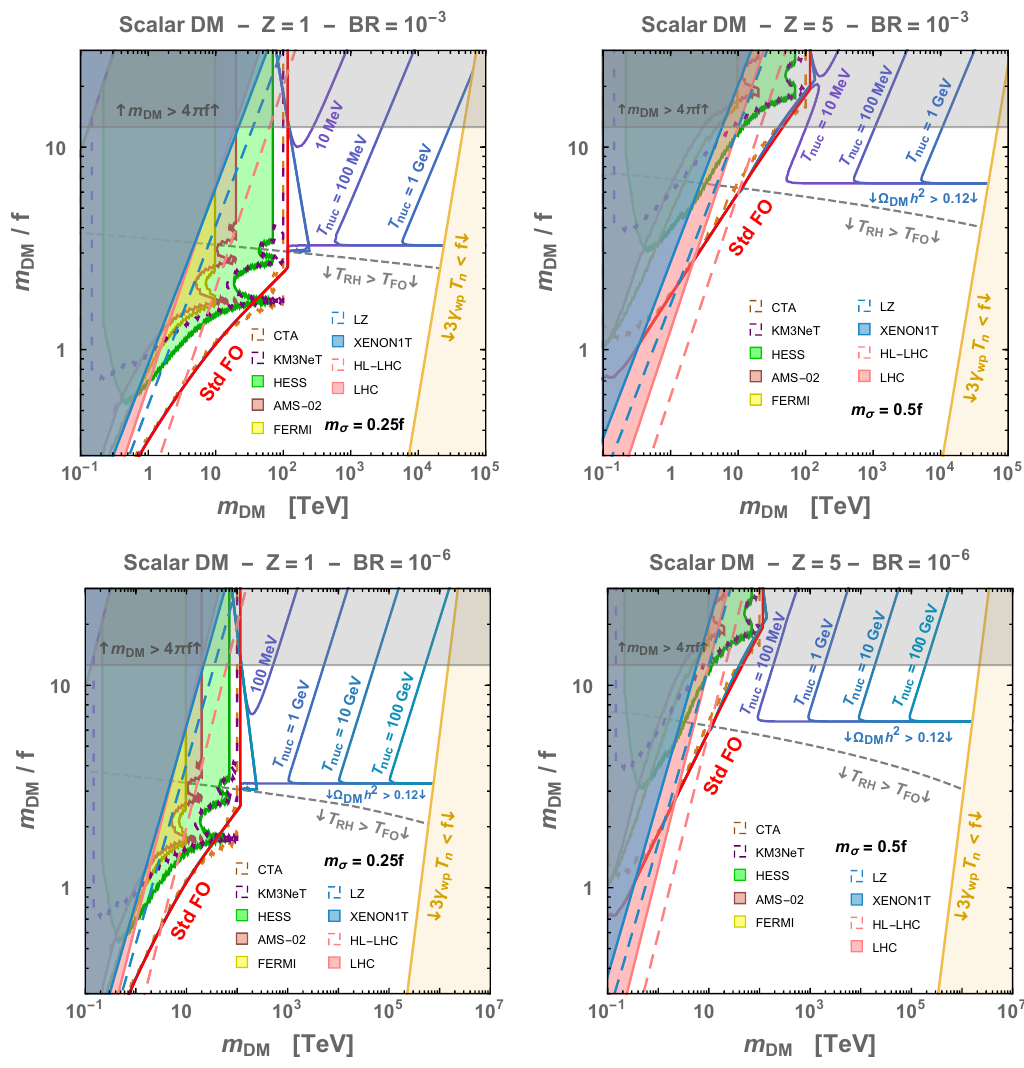
Figure 6 . Supercooled dilaton-mediated scalar DM, for branching ratio of DM production (defined in eq. (4.16)) BR = 10 − 3 (top) and BR = 10 − 6 (bottom), and for wave-function renormalization (defined in section 2.1) Z = 1 (left) and Z = 5 (right). When m